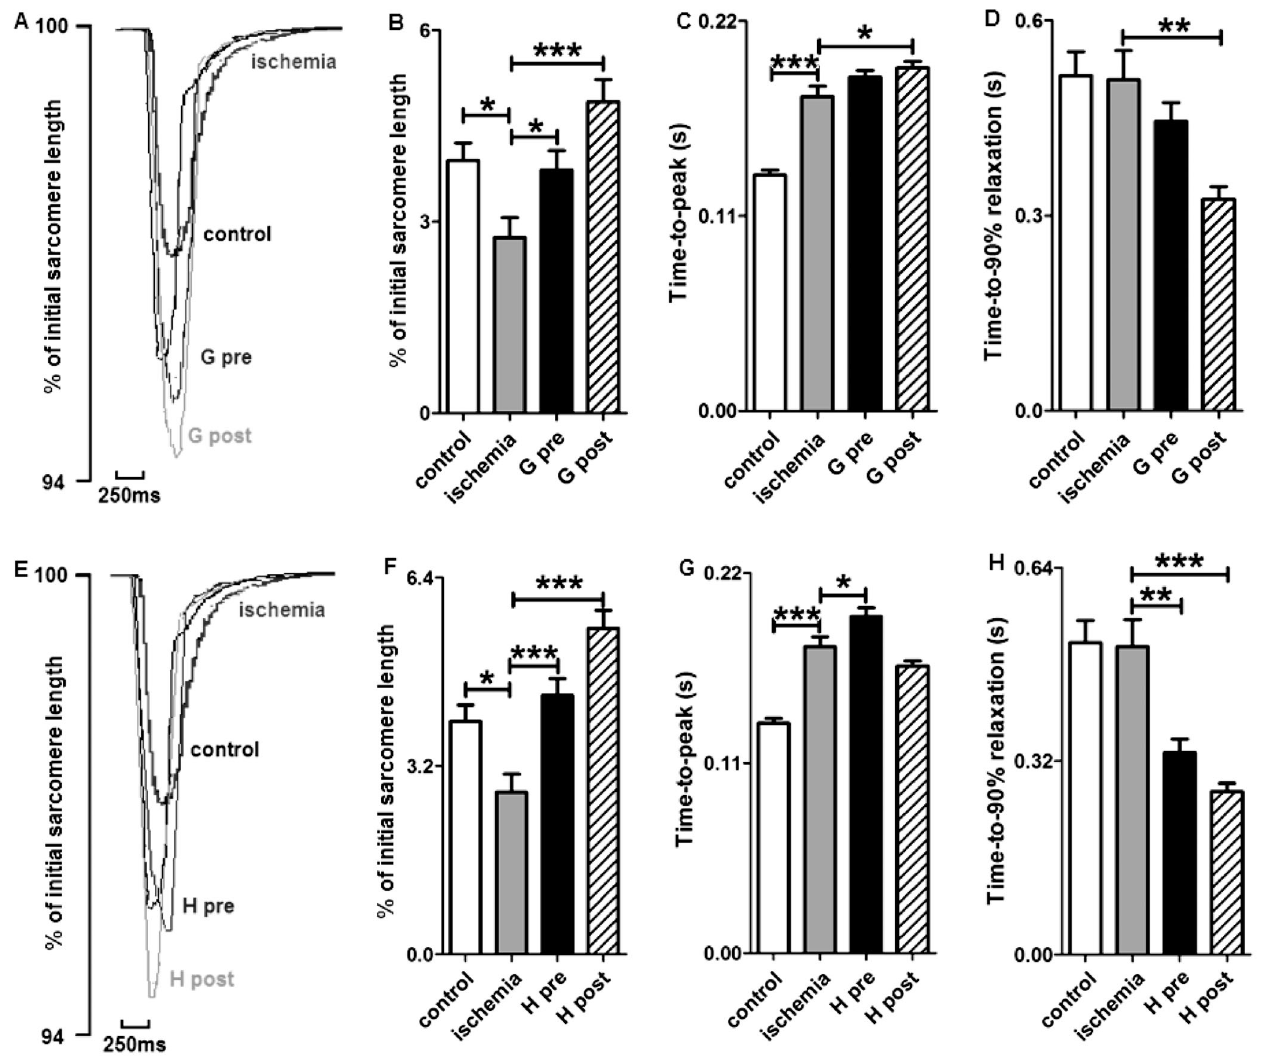
Figure 2. Effects of GHS on the contractile properties of mouse cardiomyocytes exposed to ischemia/reperfusion. (A) and (E) are representative superimposed traces of sarcomere shortening after ghrelin (G) or hexarelin (H) pre-treatment (pre) and post-treatment (post). Both hexarelin and ghrelin improved the reduction in sarcomere shortening (B and F), but not the prolonged time-to-peak shortening (C and G). The time- to-peak shortening was further prolonged in G post- and H pre-treatment groups. The time for relaxation (D and H) was shortened in G post-, H pre- and post-treatment groups. n = 99, 84, 84, 95, 106 and 100 cells/3 mice in control, ischemia, G pre, G post, H pre and H post groups, respectively. Data are shown as means 6 S.E.M. and analyzed by One-way ANOVA with Tukey’s post hoc test. * P , 0.05, ** P , 0.01, *** P , 0.001 vs ischemic group.